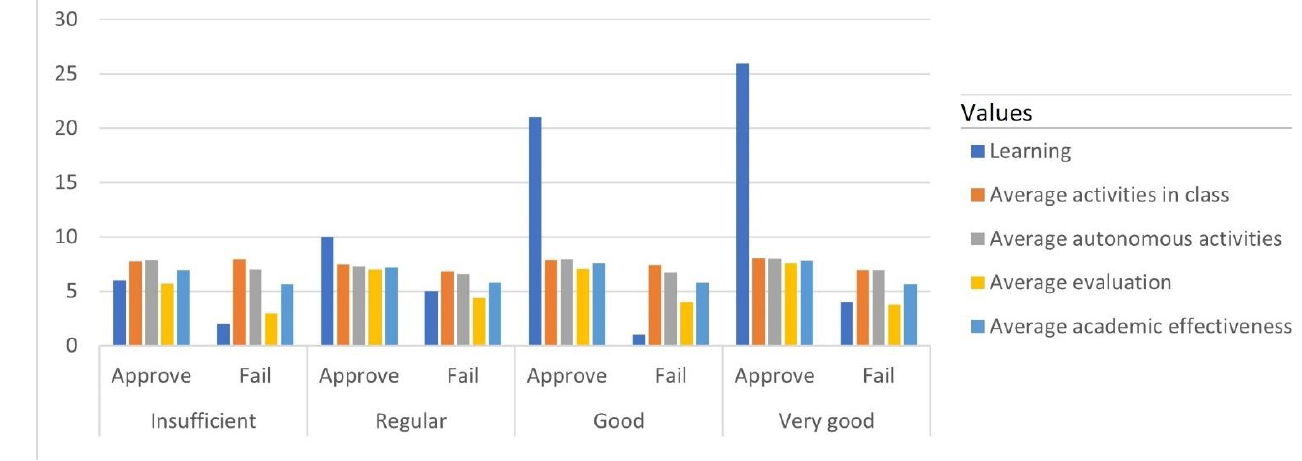
Figure 5. Graph of the trend analysis for the 2022 period.